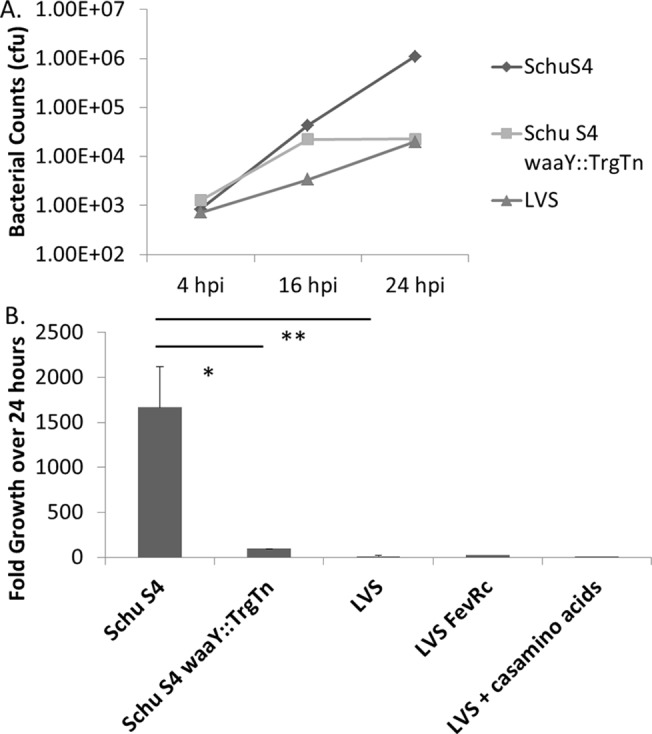
Growth of F. tularensis Schu S4, F. tularensis waaY::TrgTn and F. tularensis LVS in cultured human alveolar type II cells.Immortalized primary AT-II tissue culture cells were used to perform gentamicin protection assays. The ability of the three Francisella strains to enter and replicate with these epithelial lung cells was measured after infecting at an MOI 100:1. Fold growth was calculated as the difference between the number of bacteria surviving gentamicin treatment at 4 hours and 24 hours post-infection. (A) Data are a single experiment representative of three separate experiments. (B) Data are an average of four independent experiments.